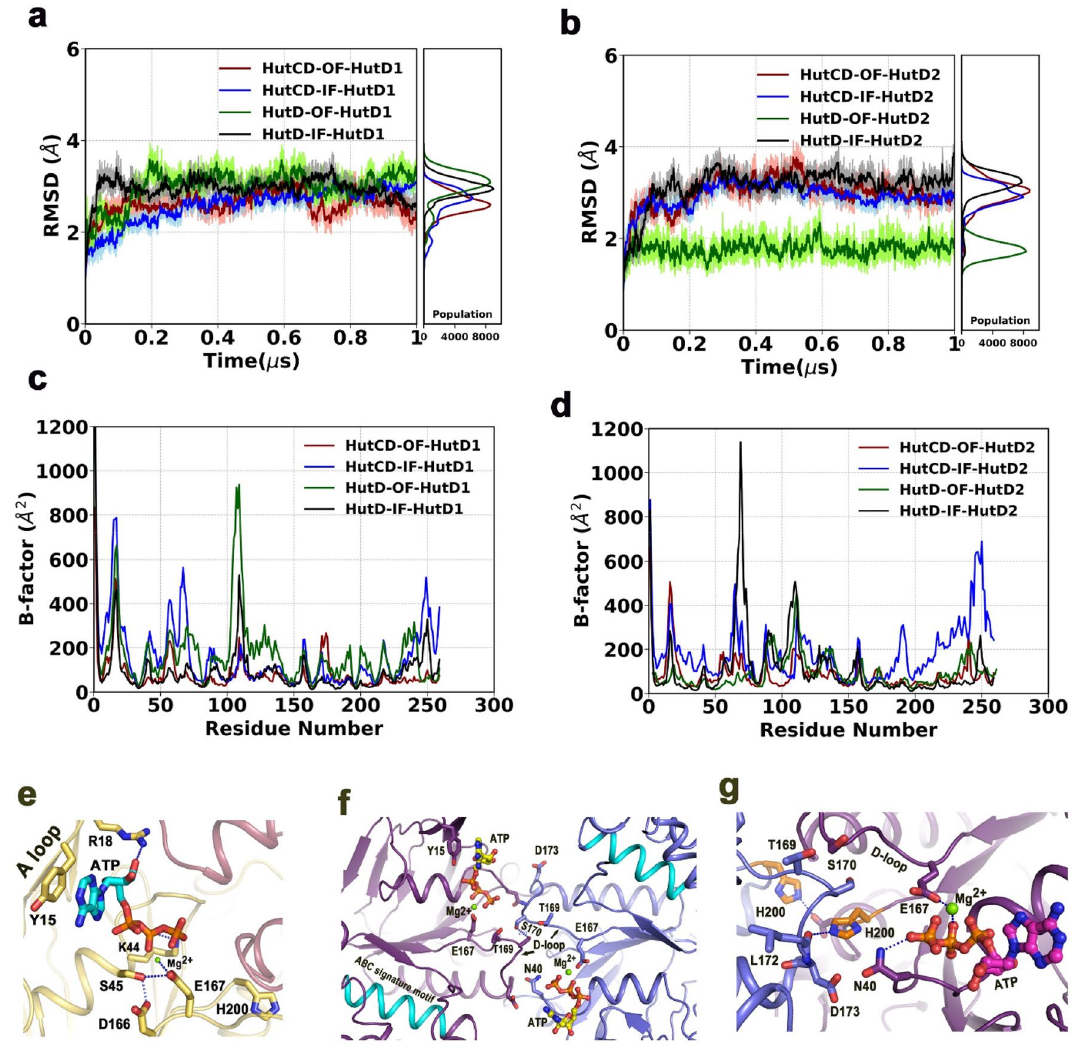
Figure 5. MD simulation results of HutD in the OF state. ( a,b ) Cα-RMSD values of HutD1 and HutD2 as part of HutD dimers and as part of HutCD assemblies in the IF and OF states; ( c,d ) B-factors of HutD1 and HutD2 as part of HutD dimers and as part of HutCD assemblies in the IF and OF states; ( e ) ATP binding in HutD OF at 200 ns showing involvement of the residues of A-loop, Walker-A and Walker-B motifs; ( f ) interaction between D-loops of two HutD monomers at 108 ns of simulation run on HutD dimer in the OF state; ( g ) disposition of H200 at 150 ns of the simulation run on HutD dimer in the OF showed asymmetry/dissimilar movements. Reduction in fluctuations in the residues 100–115 of HutD1 in HutCD indicates that not only ATP-Mg 2+ but the TMDs also help in stabilization of the complex, because of the inter- actions between L-loop of HutC and Q-loop of HutD (Figs. 4e, 5c,d). The flexibility and asymmetric nature of the A-loop (residues 12–23, Fig. 1b) are also evident for all the states, which is more distinct in case of HutD1 compared to HutD2 (Fig. 5c,d). As evident from large B-factor values, high flexibility were observed in certain surface exposed regions of HutD (Fig. 5c,d). Interactions near ATP binding site of HutD dimer.